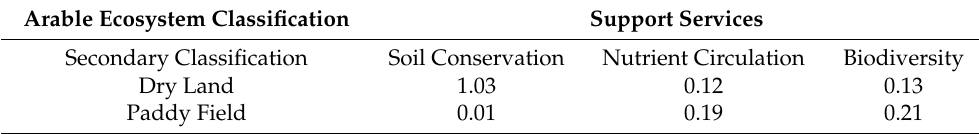
Table 1. Supporting service value equivalent of arable ecosystem per unit